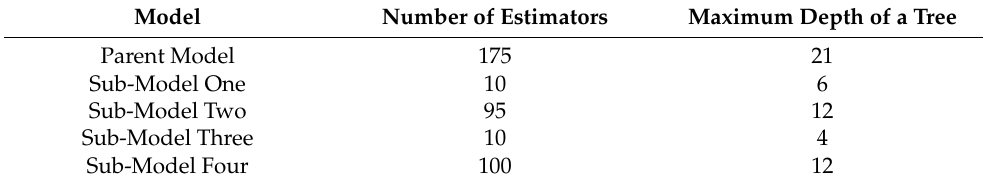
Table 4. Hyper-parameters of